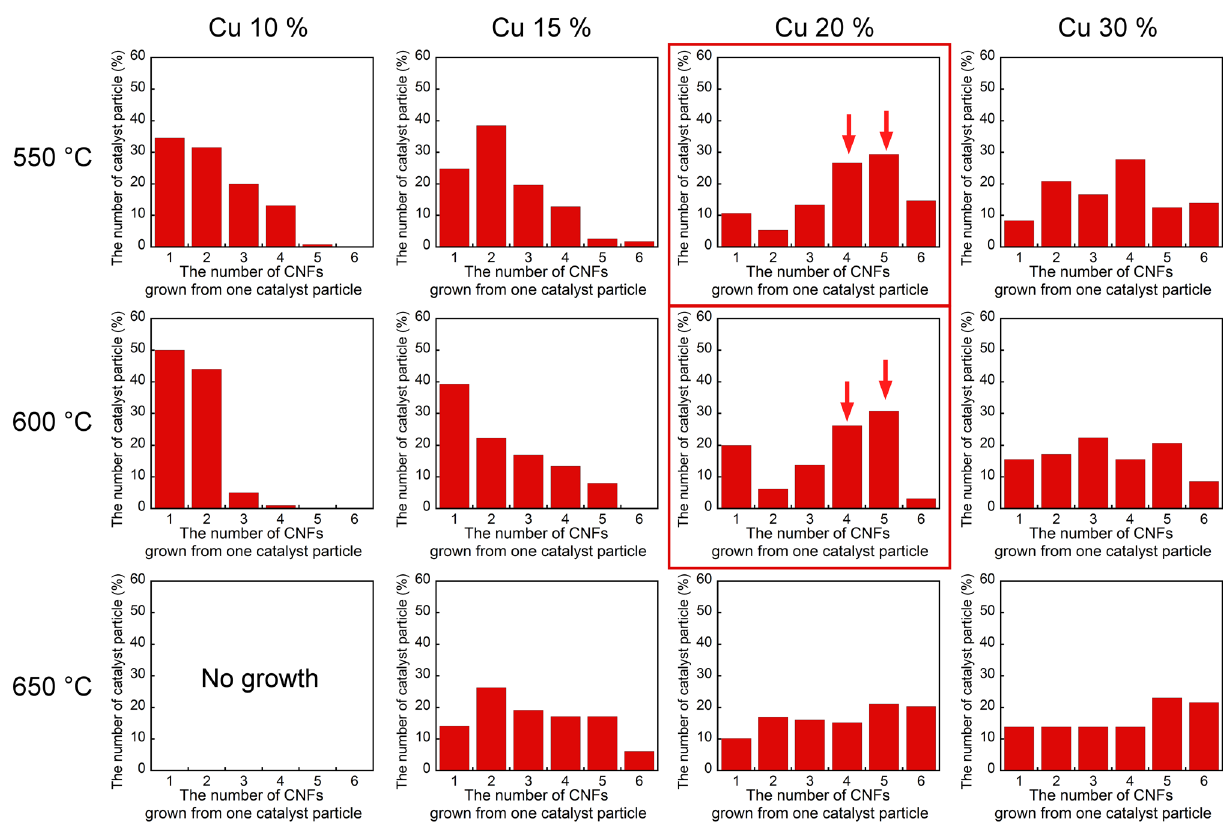
Fig. 5 The distributions of the number of CNFs grown from each of the catalyst particles counted using SEM